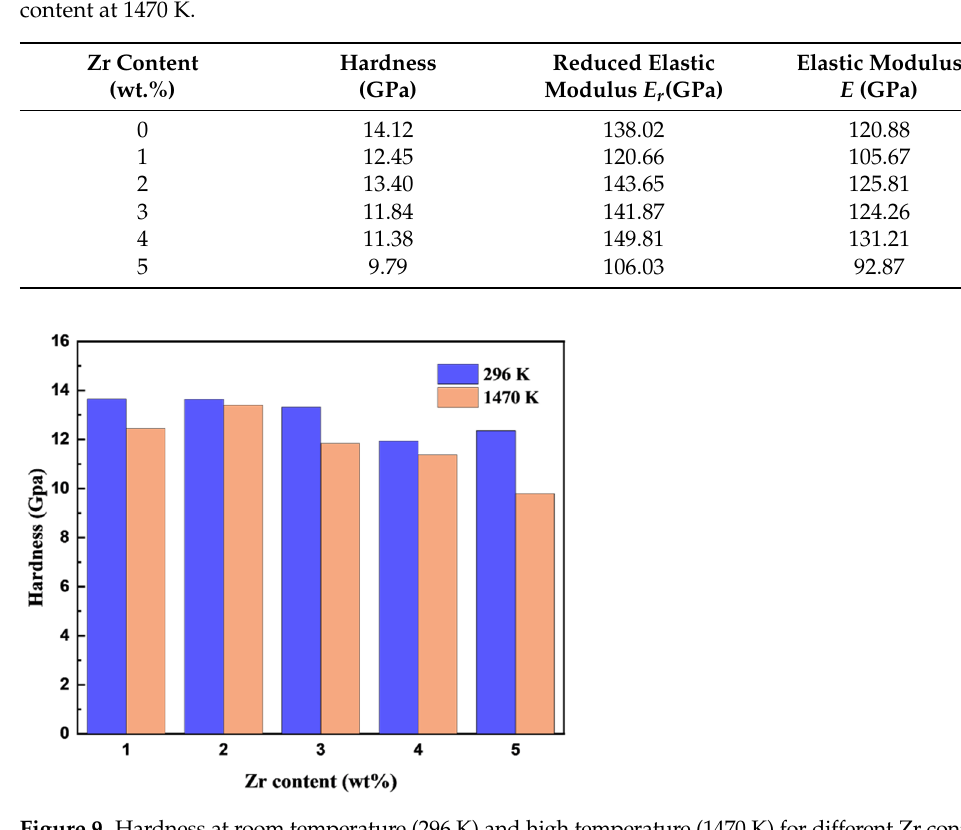
Figure 9. Hardness at room temperature (296 K) and high temperature (1470 K) for different Zr